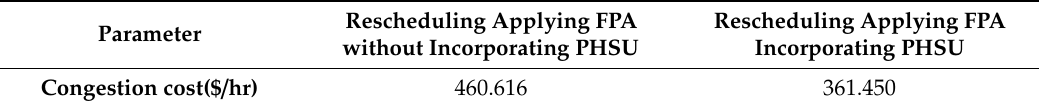
Table 12. Cost comparison with and without PHSU employing with and without FPA.